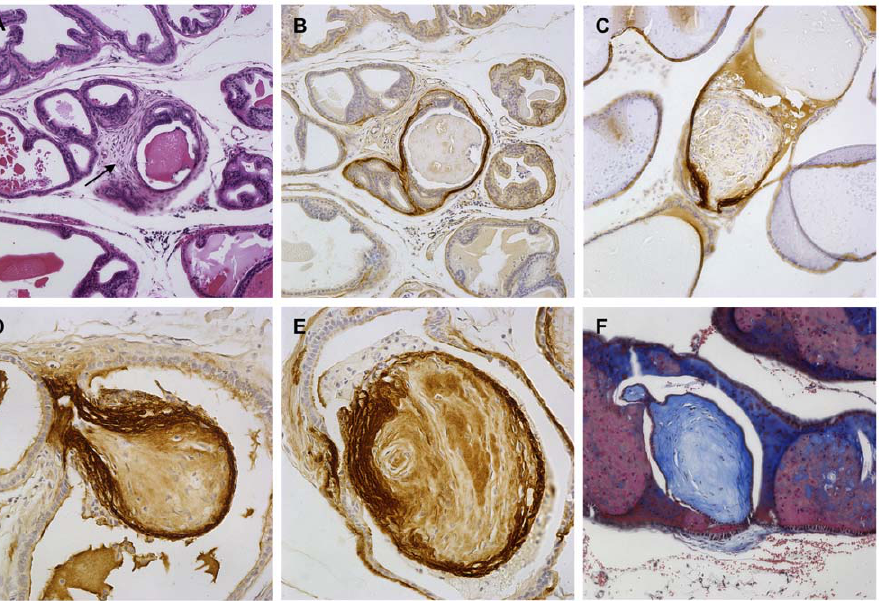
Figure 4. Fibroplasia in transgenic mice exhibits markers of reactive stroma. Serial sections showing stromal thickening ( PanelA , arrow) with increased deposition of tenascin-C ( PanelB , IHC for tenascin-C), consistent with a reactive stroma phenotype in areas surrounding some attenuated epithelial acini. PanelC . Tenascin-C immunoreactivity is also deposited near the base of stromal micronodules. PanelDandE . Tenascin-C deposition appears to form lamellar layers near the base and periphery of stromal micronodules. PanelF . Masson’s trichrome staining indicates nodules are composed of collagen (blue). Images A–D & F were captured at 6 200 and image E at 6 400 magnification.